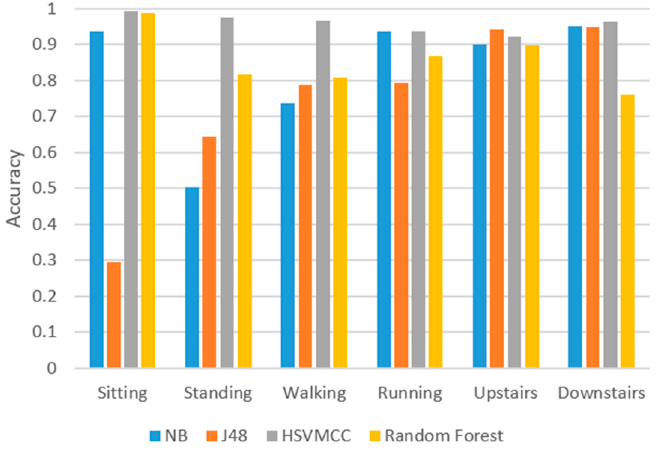
Figure 8. Comparison of the proposed ARS vs. classification models, J48, NB and Random Forest.